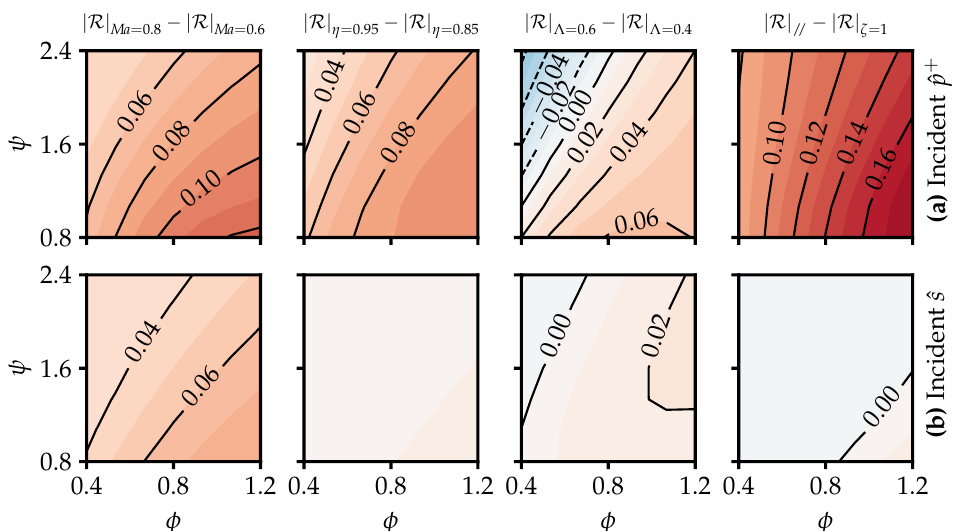
Figure 8. Effect of secondary parameter variations on acoustic impedance, for incident downstream- running pressure and entropy waves. Contours of sensitivity calculated by subtracting acoustic impedances at the upper and lower limits of each parameter, with other parameters at datum values.